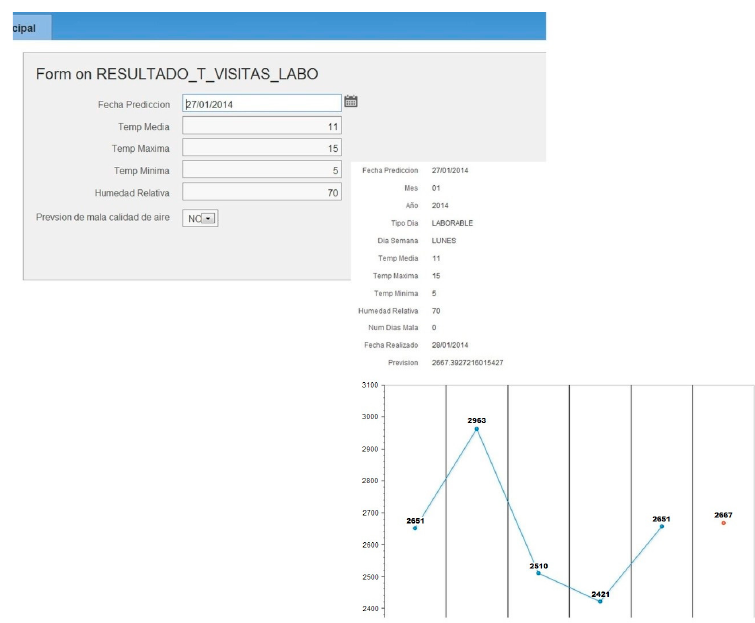
Figure 12. Design of the main screens of the decision support